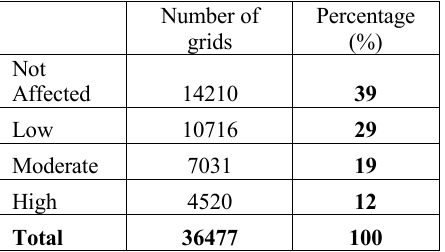
Table 5. Total number of grids in Candelaria, Zambales